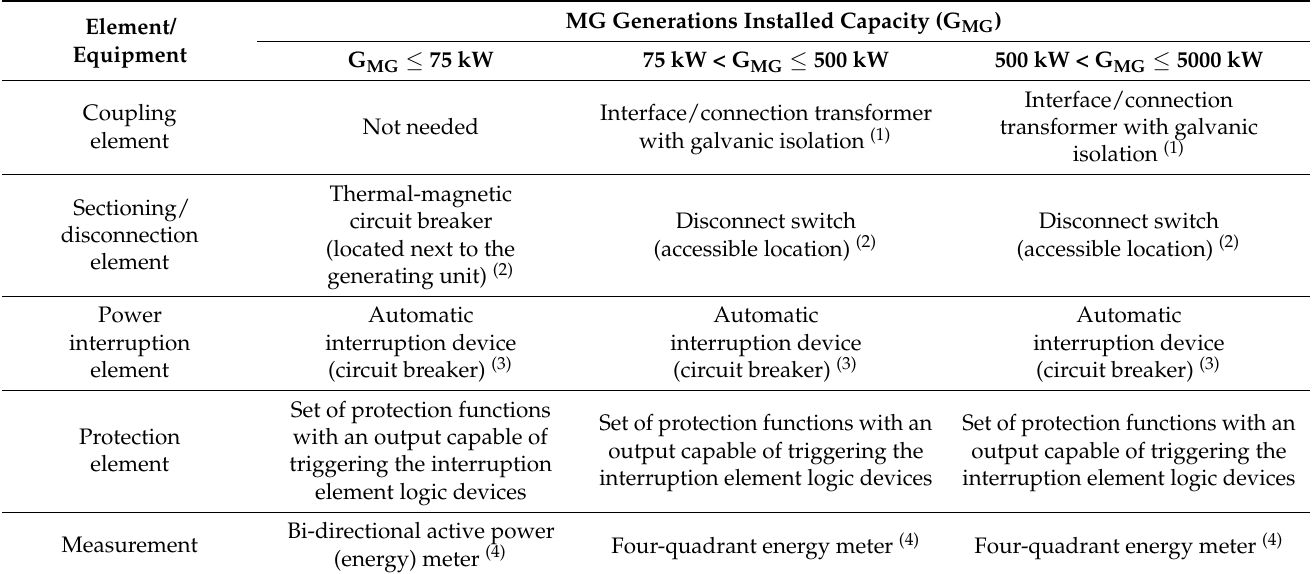
Table 4. Minimum interface requirements for DG up to 5 MW (microgeneration or mini-generation)— according to ANELL Normative N ◦ 1059